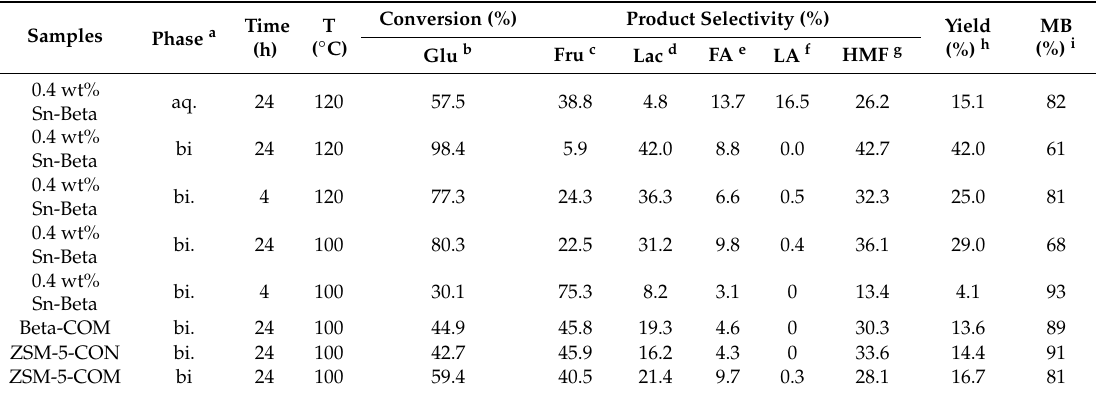
Table4. Catalyticperformancesinglucoseconversionto5-hydroxymethylfurfural(5-HMF)inthebiphasic phase (dioxane / water) over different catalysts at different reaction times and reaction temperatures.